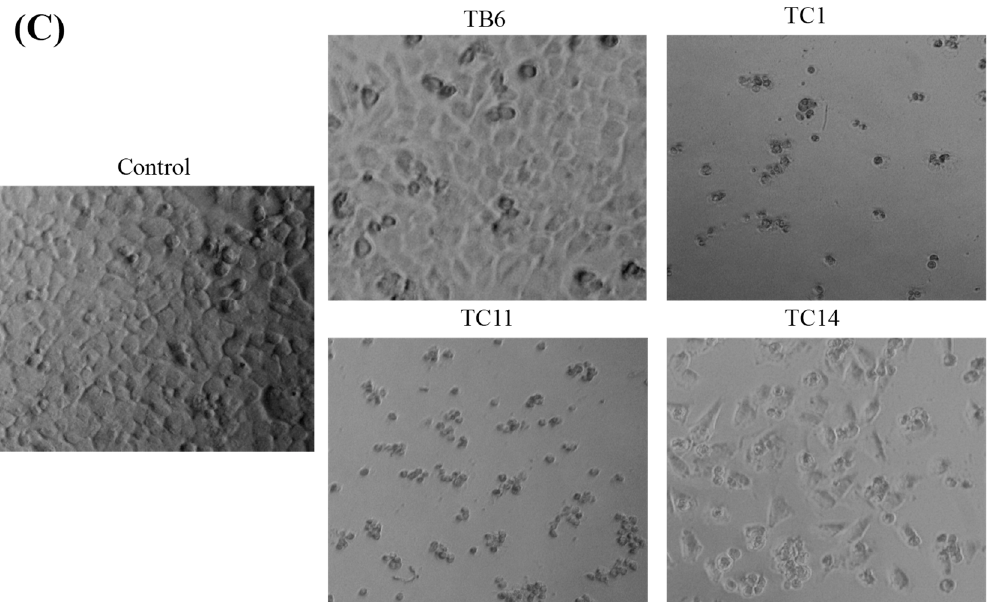
Figure 3. Effects of the active compounds on PC3 ( A ), K562 ( B ), and WM9 ( C ) cell growth and apoptosis. Cell number and morphological appearance of the two types of cell lines treated with 2.5 µmol/L of active compounds, then, it was observed by a fluorescent inverted microscope after 24 h. Scale bar = 100 µM in all images. All experiments were performed in triplicate.